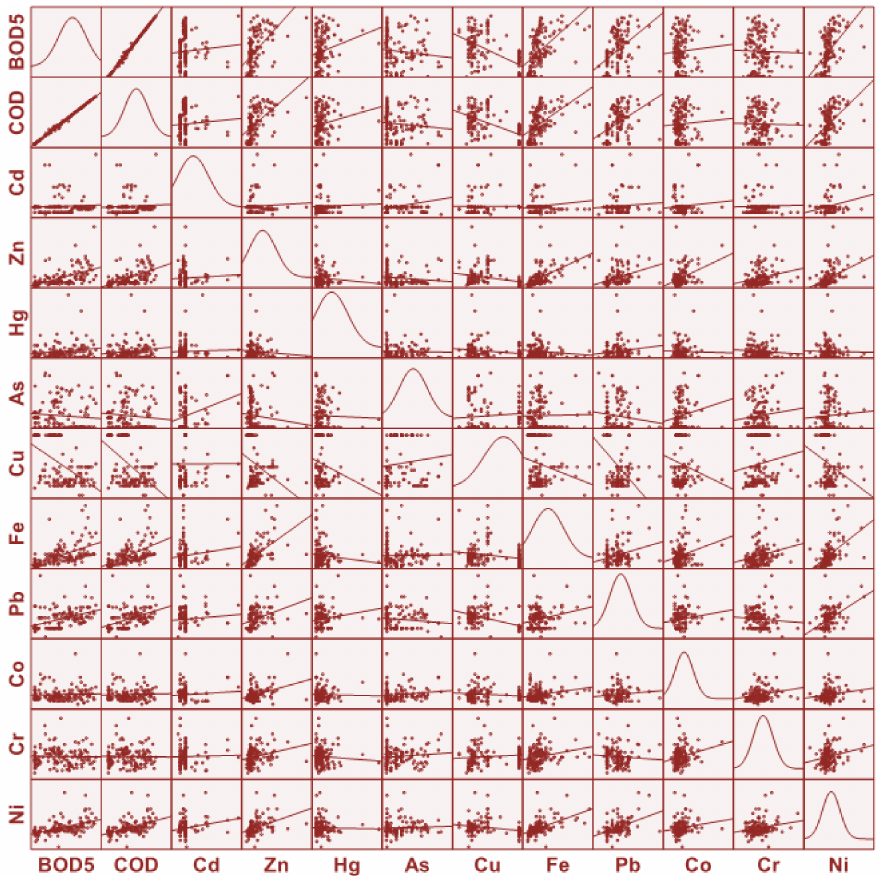
Figure 2. Pearson’s correlation matrix between chemical characteristics of untreated leachate during the study